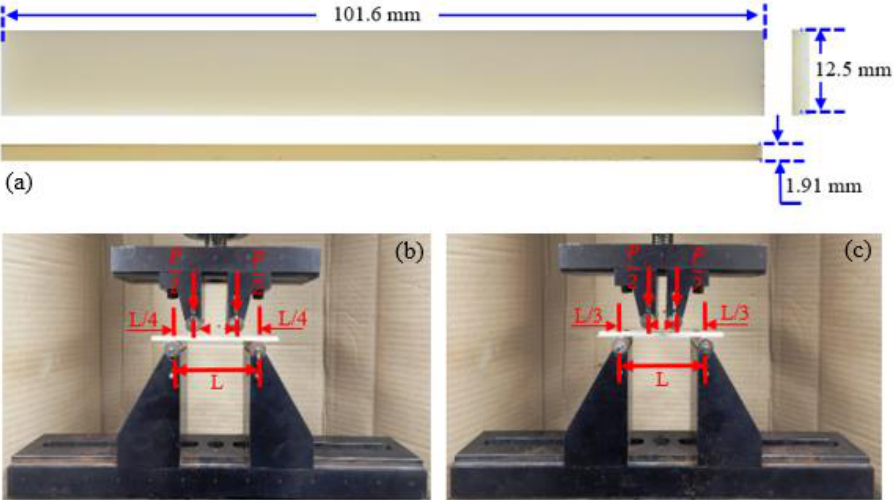
Figure 1. ( a ) Geometric dimensions of the four-point bending test specimen; ( b , c ) four-point flexural test setup pertaining to two span lengths.